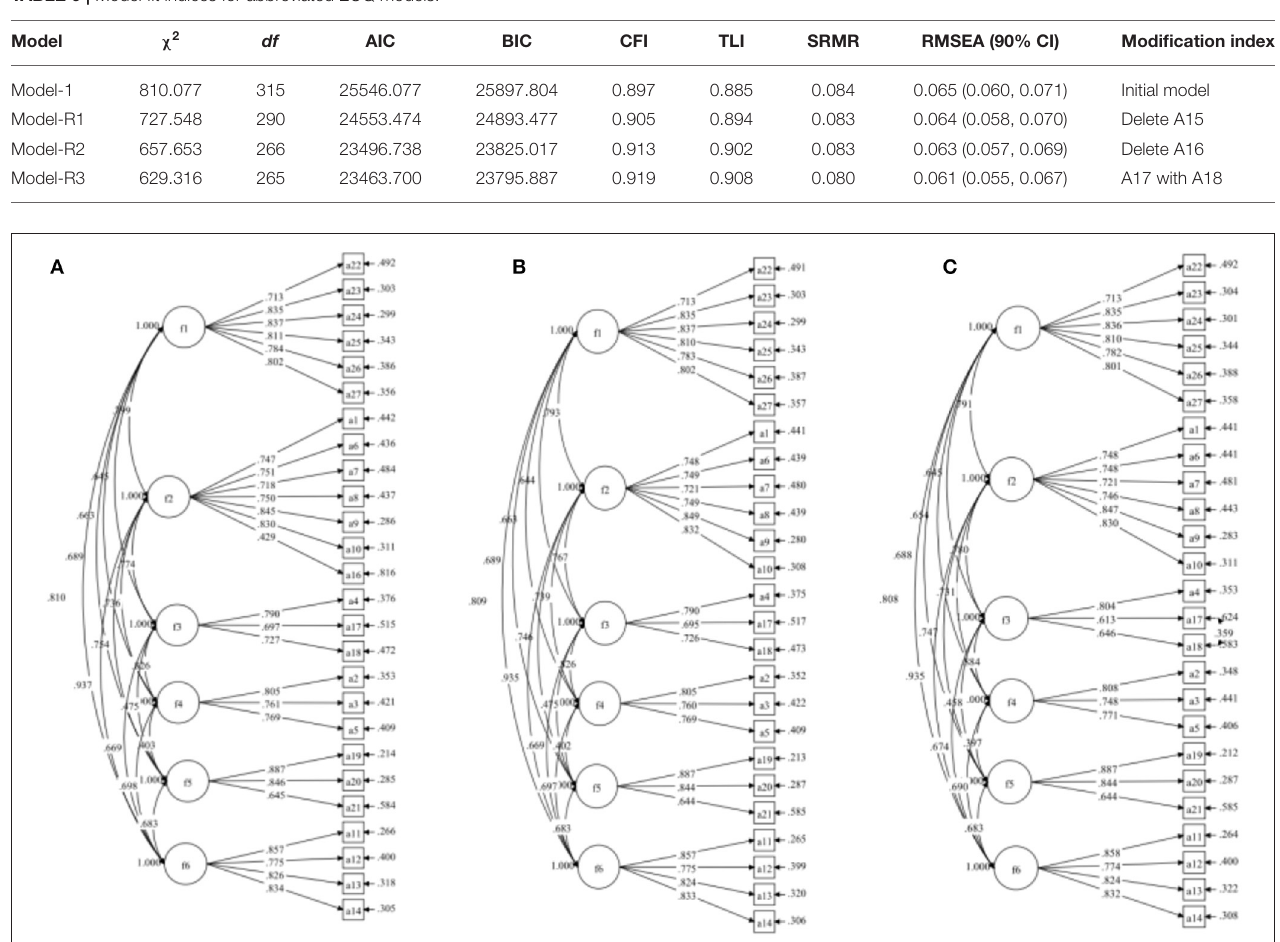
compared with the configural model, were within recommended values ( 1 CFI = − 0.003, 1 TLI = 0, 1 RMSEA = 0). This indicated that the items used to estimate the factor loadings had the same meaning for males and females. The